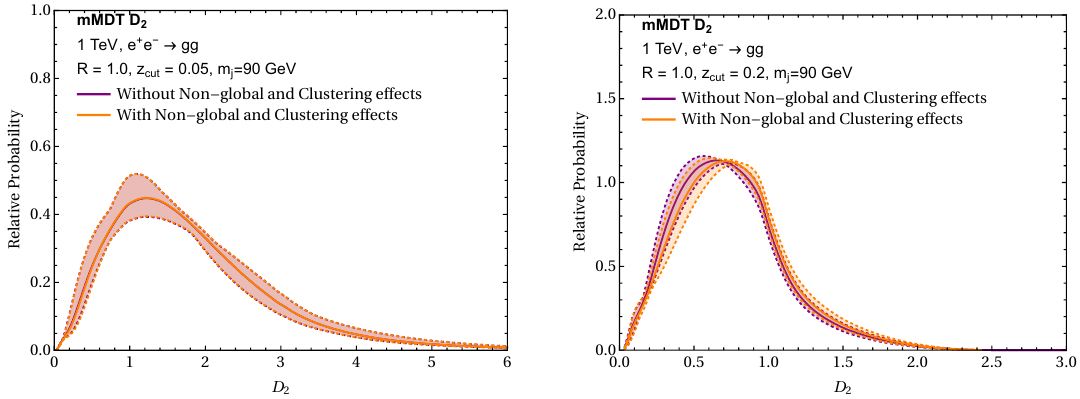
Figure 6 . The D 2 relative probability spectra, for a variety of groomed jet masses for gluon initiated jets, and comparing the change in the spectrum with the inclusion of non-global and clustering e(cid:11)ects. We give the e(cid:11)ect on the distribution for gluon jets for z cut = 0 : 05 and 0 : 2 for m J = 90